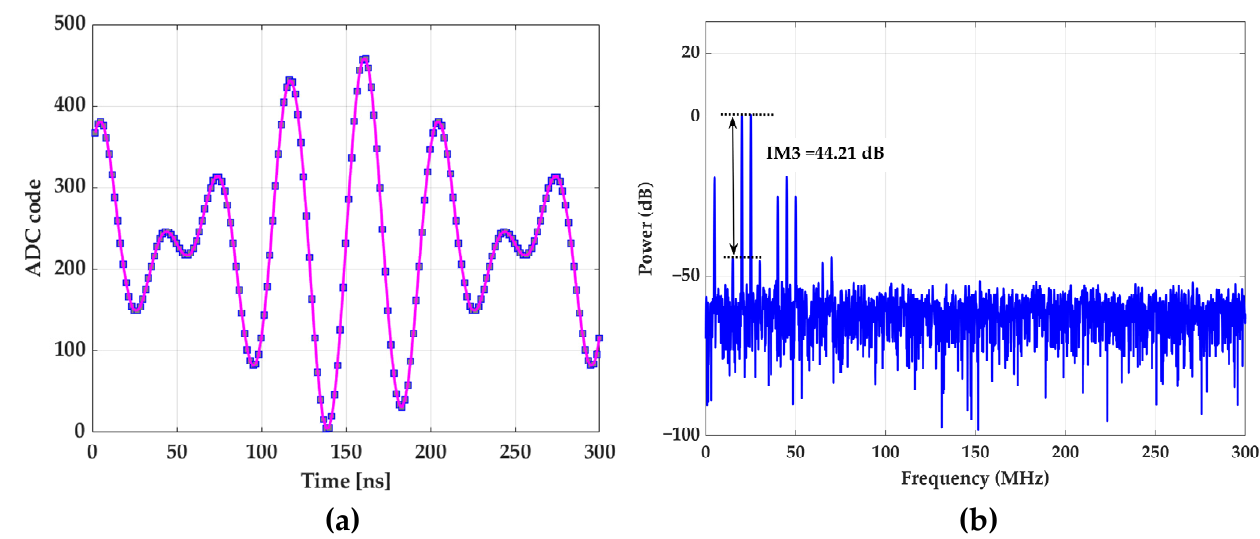
Figure 17. Two-tone test at 20 and 25 MHz. ( a ) Time domain; ( b ) frequency domain. The ADC dynamic performance is analyzed by measuring SNDR versus input amplitude. The unit of abscissa dBFS is equal to 20 log amplitude and A full _ range is the full range. As Figure 18 shows, SNDR increases linearly when the input signal amplitude increases.